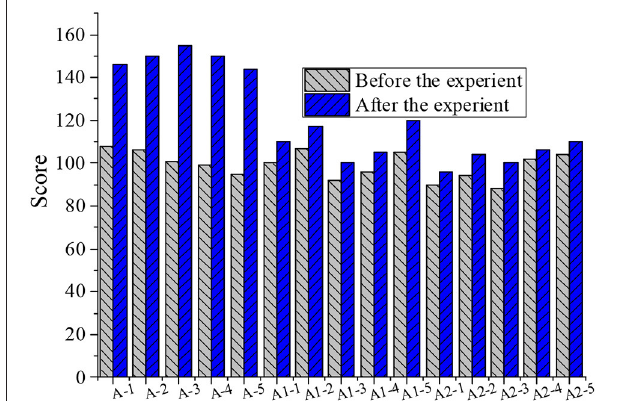
FIGURE 1 | Comparison of piano learning attitudes between groups before and after the experiment in grade 2 (A refers to the experimental group A, A1 refers to the A1 control group, and A2 refers to the A2 control group. − 1, − 2, − 3, − 4, and − 5 refer to the numbers of the five students, respectively).